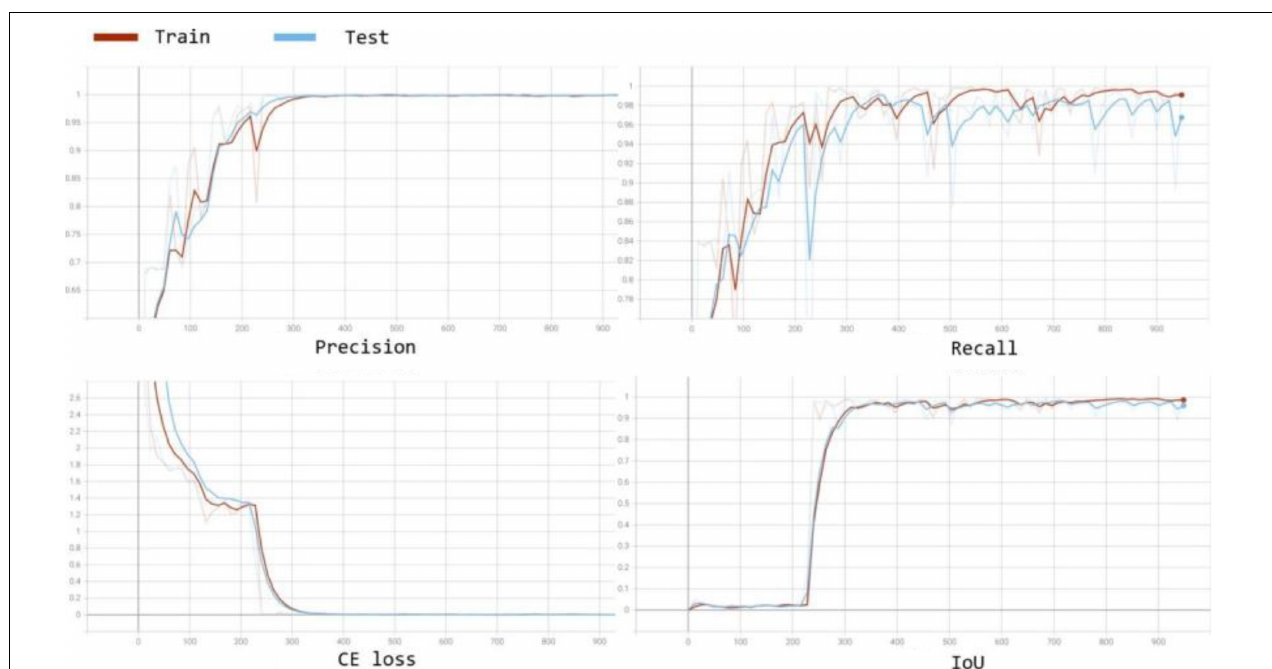
FIGURE 6 | Convergence curves for accuracy, loss, and IoU score on the validation set during the training process for comparison in terms of accuracy and convergence rate.